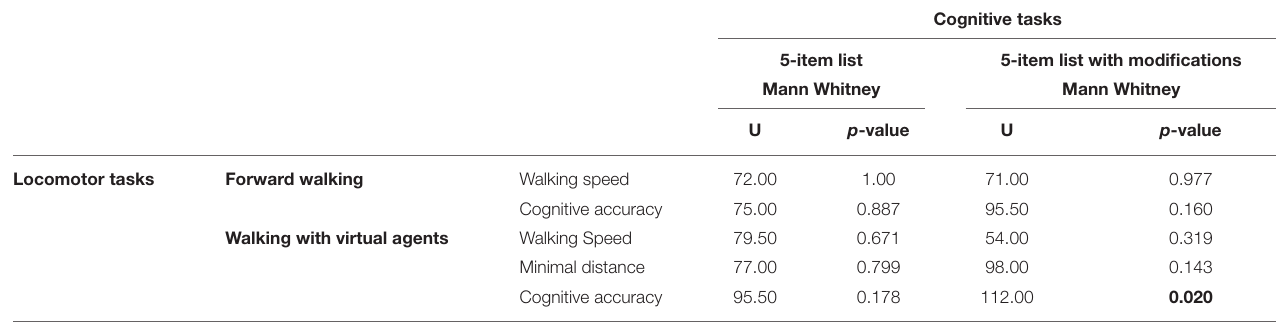
TABLE 3 | DTC comparisons between